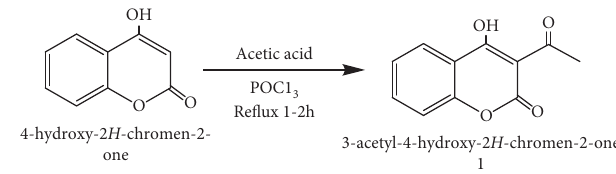
Figure 1: Synthesis of 3-acetyl-4-hydroxycoumarine.